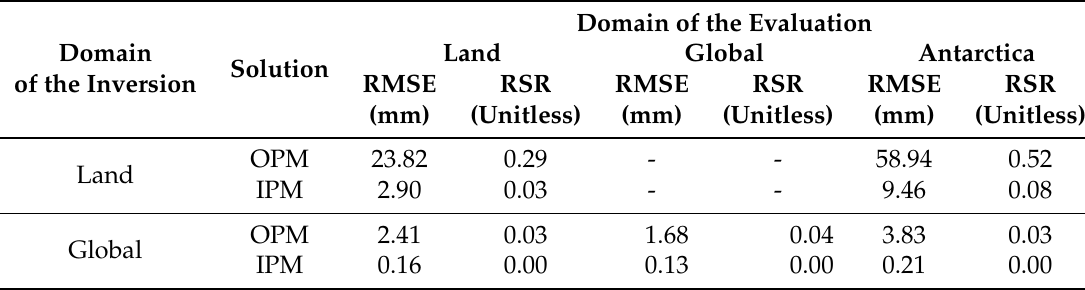
Figure 4. Root-mean-square errors (RMSEs) between the input mass changes from GSFC-M and those inverted from the OPM and IPM solutions over Antarctica. The panels ( a , b ) shows the RMSE regarding the recovering of mass changes only over the continents for OPM and IPM solutions, respectively. Similarly, to panels ( a , b ), panels ( c , d ) show the summary considering the results of the inversion accounting for a global set of mass changes. Table 1. Summary of quantitative statistics for the assessment of OPM (zeroth-order approximation) and IPM (third-order approximation) solutions based on a closed-loop